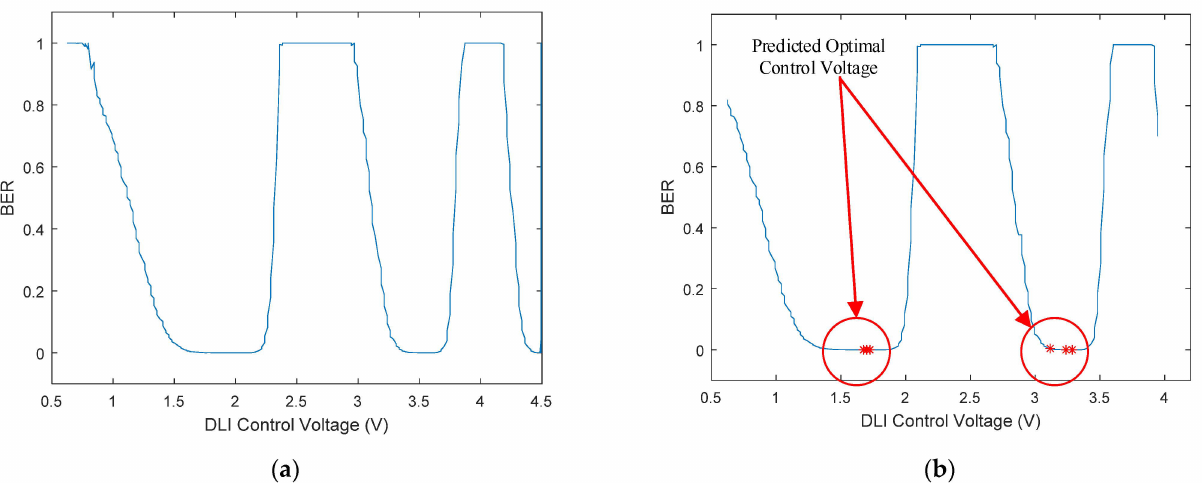
Figure 11. Implementation performance of the proposed method in FPGA: ( a ) represents the BER curve of the training data; ( b ) marks the predicted optimal control